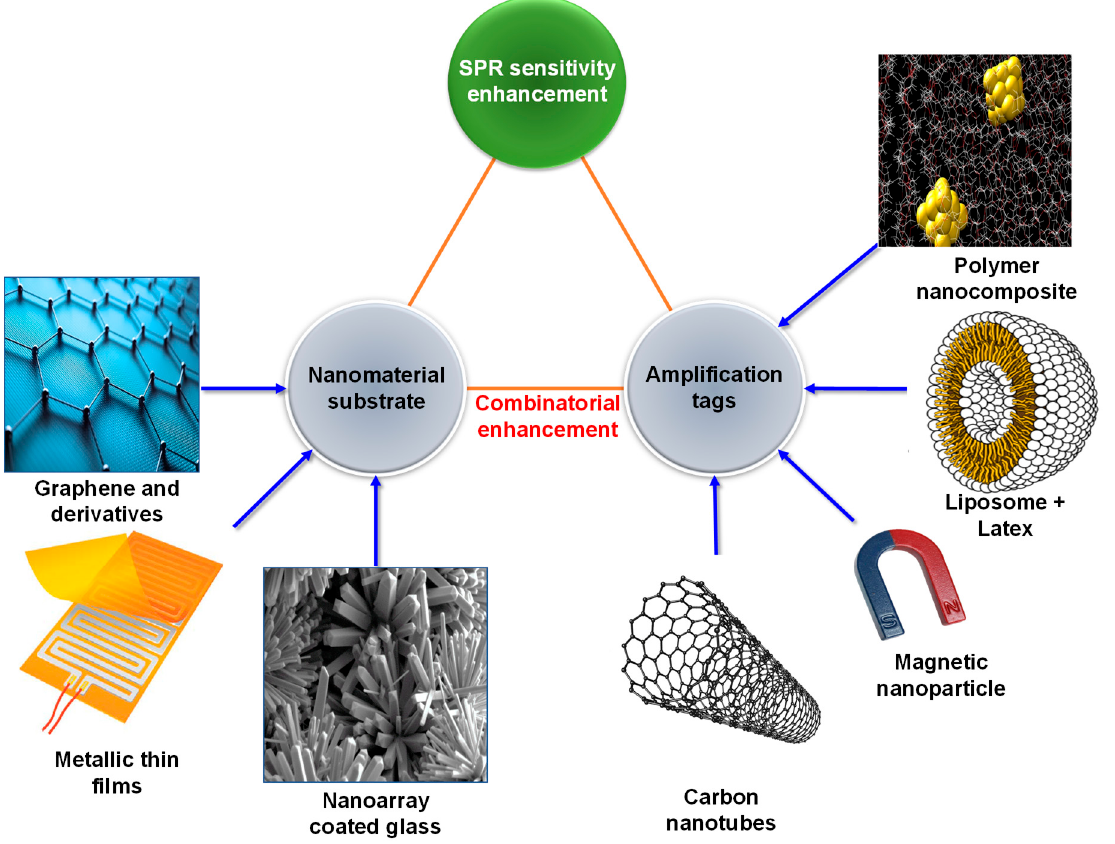
Figure 3. Various strategies to enhance the signal of SPR sensors.